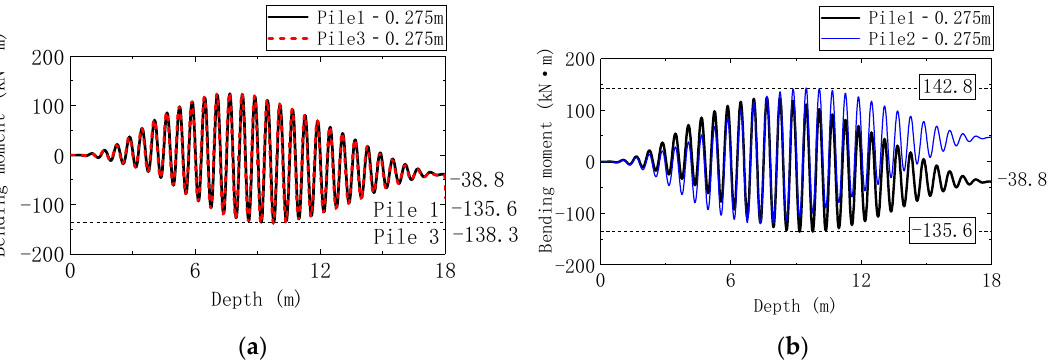
Figure 19. Bending moment envelopes of different piles: ( a ) Pile 1 and Pile 3; ( b ) Pile 1 and Pile 2.